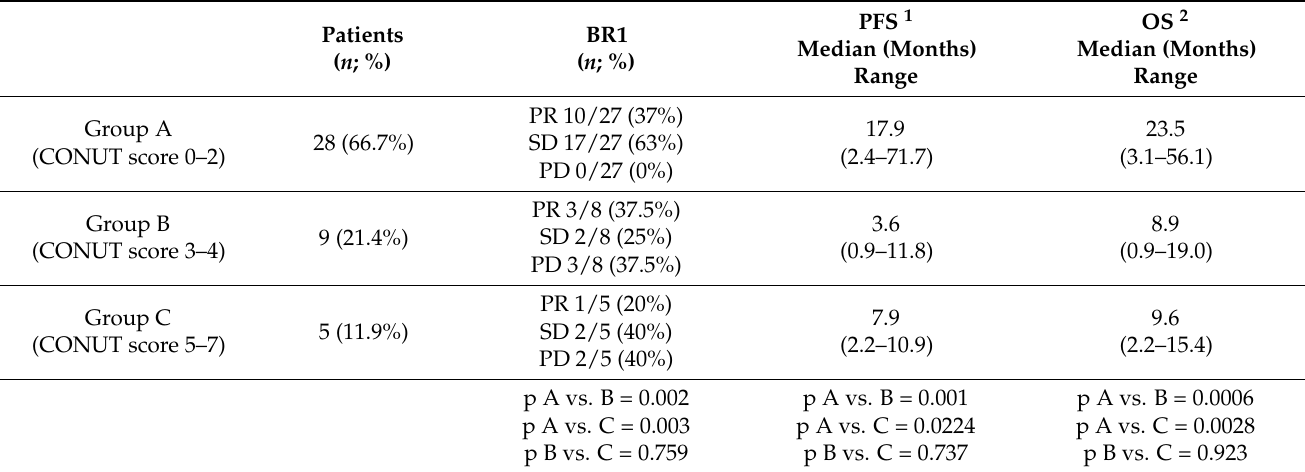
Table 2. Response to TKIs according to baseline CONUT score (Group A score 0–2, Group B score 3–4, Group C score